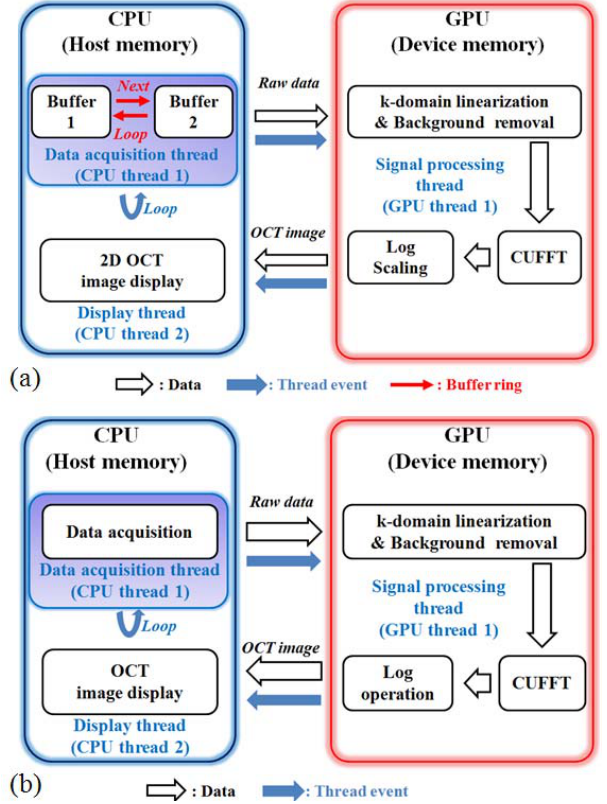
Figure 4. Program block diagram. ( a ) SD-OCT Program block diagram; ( b ) SS-OCT Program block diagram.